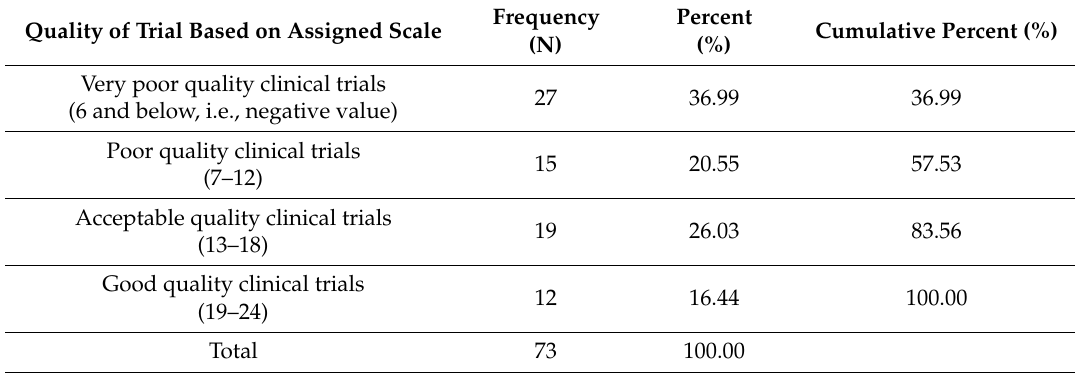
Table 7. Final in-house scoring for the clinical